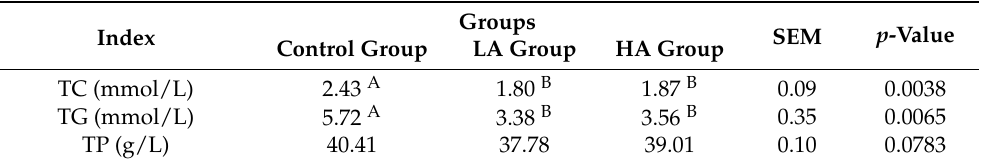
Table 6. Effects of dietary-supplemented Gynostemma pentaphyllum on the serum biochemical indexes of laying